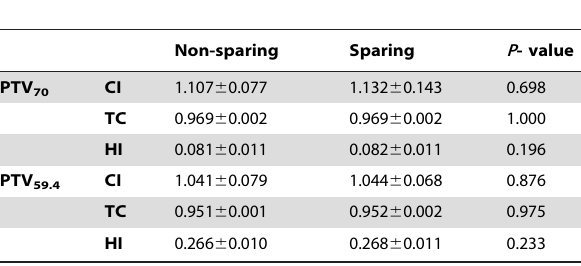
Table 3. Statistical comparison of HPC sparing and non-HPC sparing IMRT